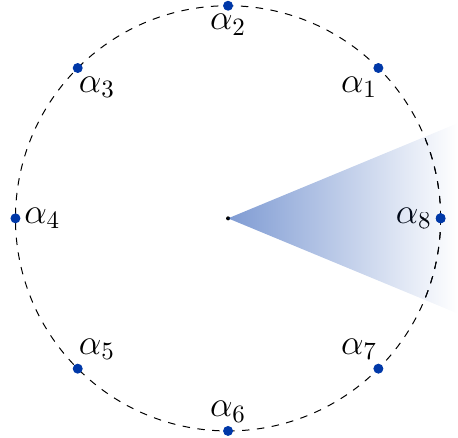
FIG. 9. A constellation of M coherent states distributed with phase separation 2 π/ M with M = 8.